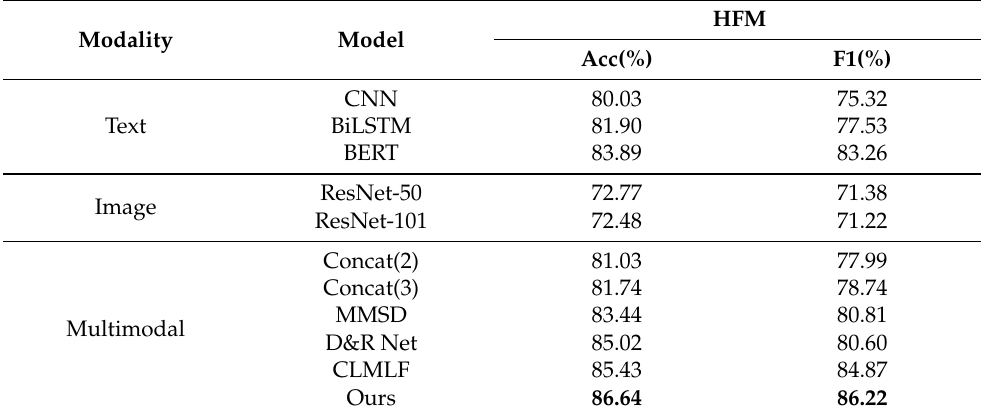
Table 3. For the HFM set, the results in the table show the ACC and F1 performance (%) of our design model evaluation metrics. Our experimental results are highlighted in